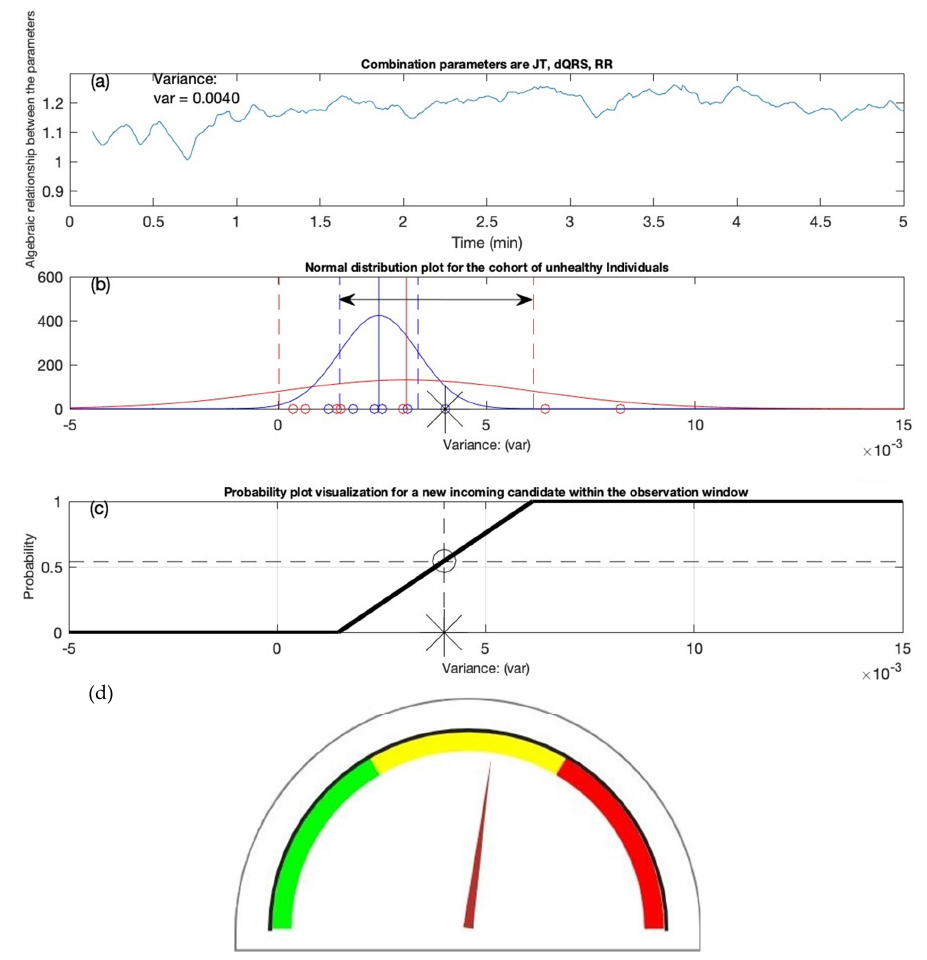
Figure 7. Test candidate #2. ( a ) The algebraic relation is shown for the combination of JT, QRS, and RR intervals. ( b ) The classification of the candidate is marked with an asterisk indicator. ( c ) The decision support system recommends the probability of the AF equal to 0.54. ( d ) The semi-gauge representation is exhibited for the candidate with the arrow of the gauge pointing towards yellow, indicating that the person is classified as an unhealthy individual.